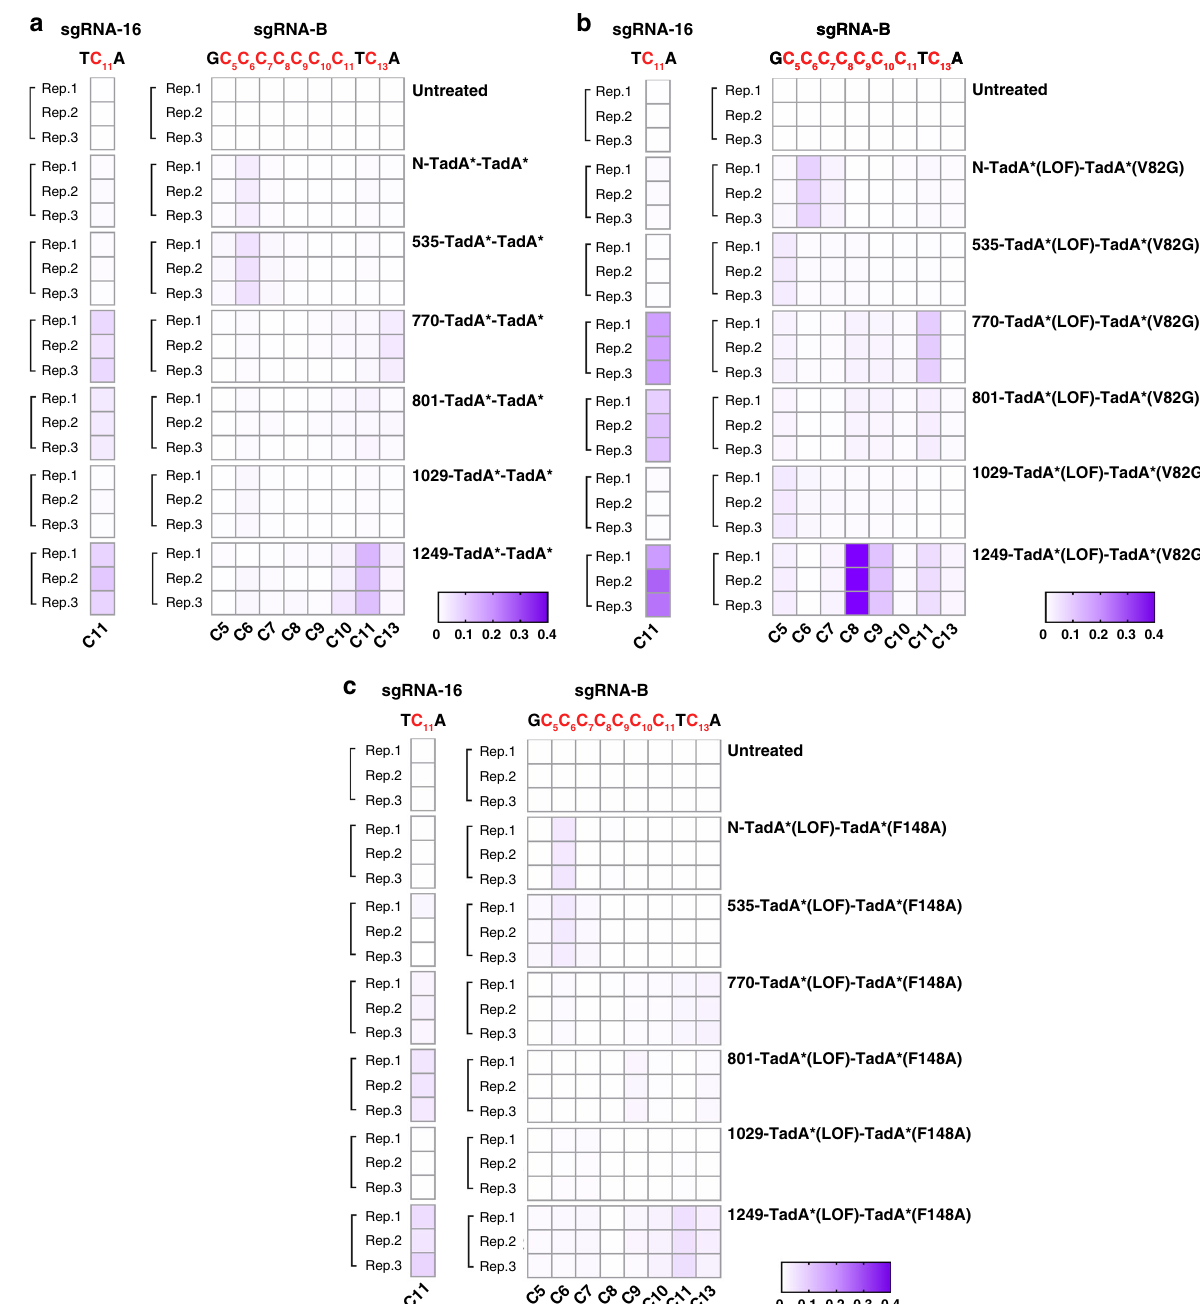
Fig. 6 Cytosine deamination activities of selected ABE-nSpCas9-DS variants and N-terminal counterpart. Cytosine deamination activities of selected ABE (TadA*-TadA*)-nSpCas9-DSs ( a ), ABE (TadA*(LOF)-TadA*(V82G))-nSpCas9-DSs ( b ), ABE (TadA*(LOF)-TadA*(F148A))-nSpCas9-DSs ( c ), and N- terminal counterpart against sgRNA-B and sgRNA-16. cytosines in sgRNAs were labeled as red. Source data are available in the Source data fi le.